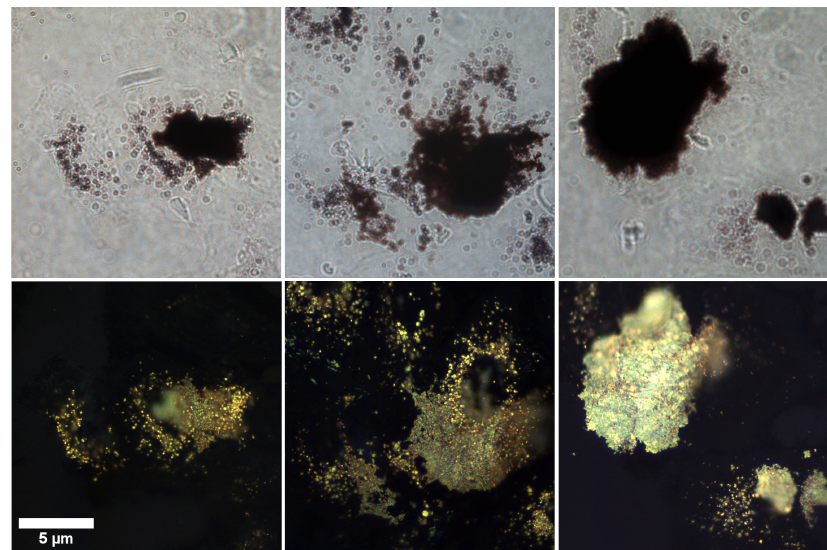
Figure 5. Large AuNR aggregates were apparent when a high volume (20µL) of biotinylated anti-EGFR antibodies were used in the conjugation process of the S-Au40-849s, after 24 h of incubation.